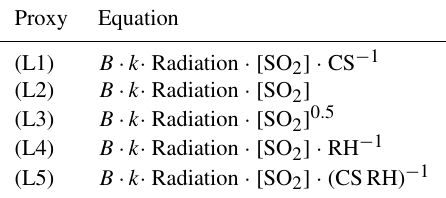
Table B1. Linear proxy functions for sulfuric acid parameterisation; reproduced from Mikkonen et al. (2011), Table